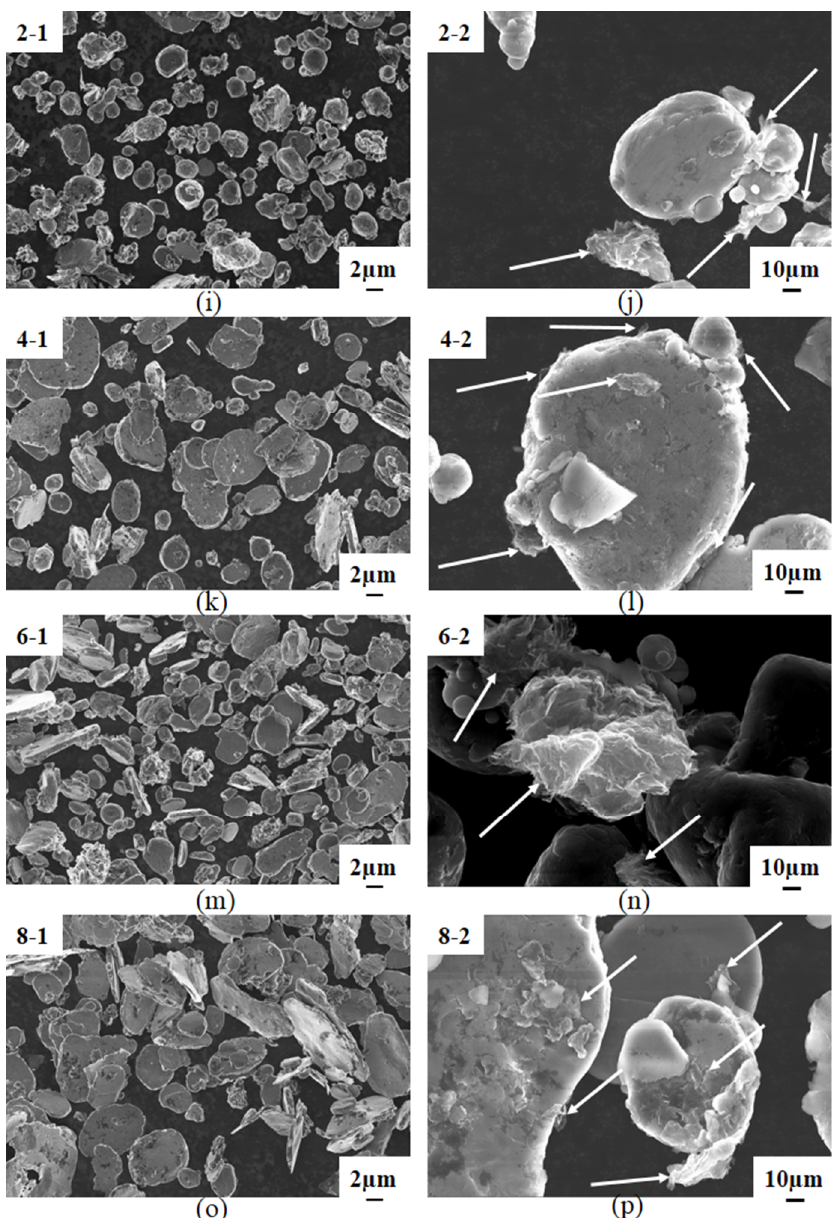
Figure 6. SEM image of the composite powder after ball milling. ( a )–( h ) 200r/min; ( i )–( p ) 300 r/min.